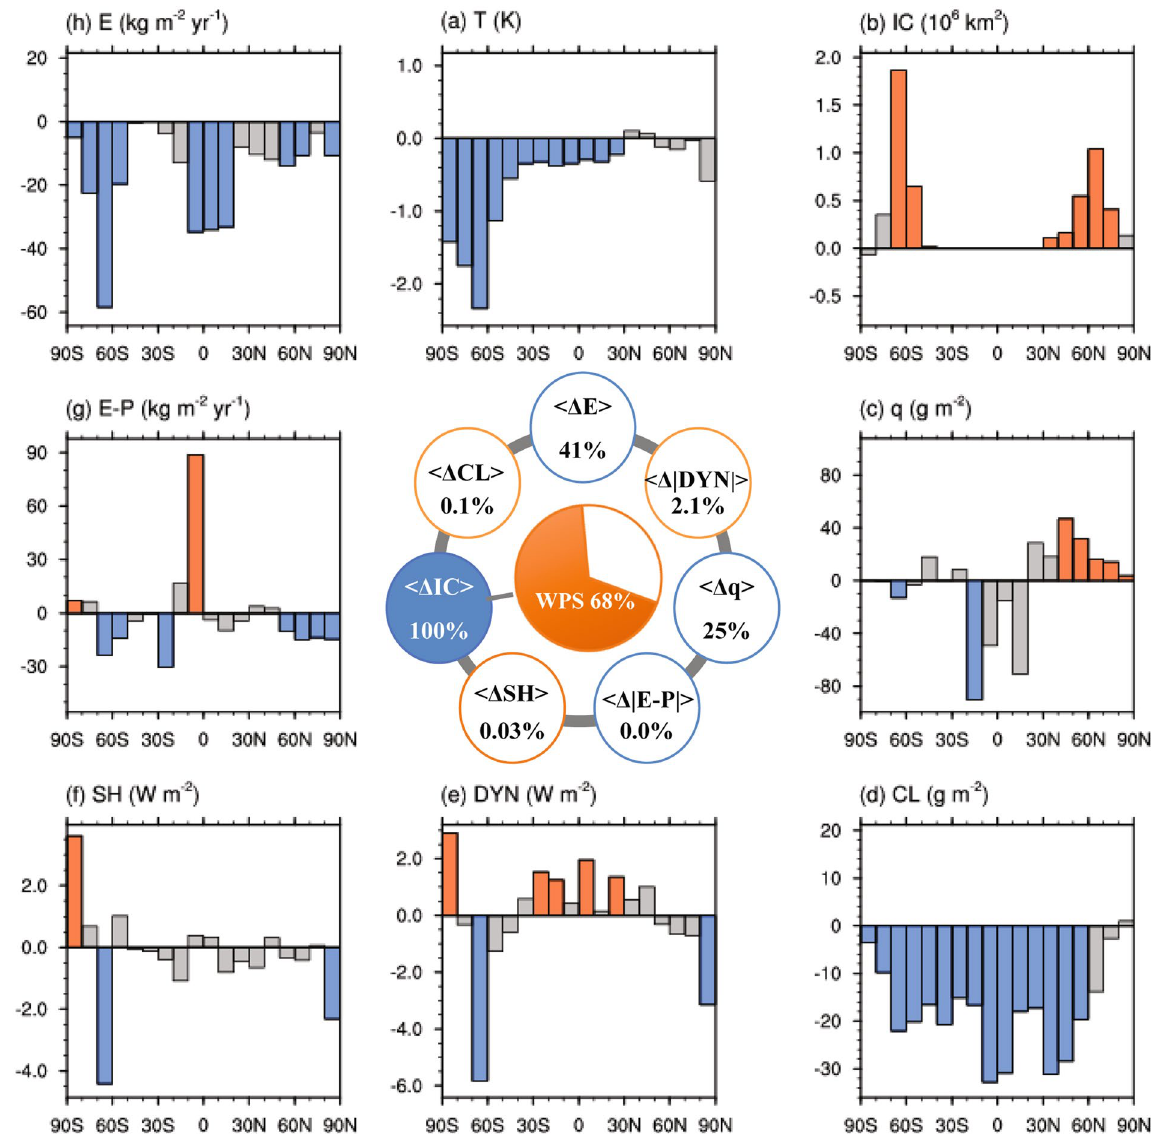
Figure 3. Latitudinal profiles (outer panels) of the regressed spreads of the zonal mean control climate states ( a – h ) against the projected spread in the change of total area coverage by ice/snow. ( a ) Surface temperature ( T in units of K), ( b ) total area covered by ice/snow ( IC in units of km 2 ), ( c ) vertically integrated atmospheric water vapor content ( q in units of g m − 2 ), ( d ) vertically integrated cloud water/ice content ( CL in units of g m − 2 ), ( e ) net downward radiative fluxes at TOA which measures the strength of the total atmosphere-ocean energy transport ( DYN in units of W m − 2 ), ( f ) surface sensible heat flux ( SH in units of W m − 2 ), ( g ) difference between surface evaporation rate and precipitation rate ( E − P in units of kg m − 2 yr − 1 ), and ( h ) precipitation rate ( P in units of kg m − 2 yr − 1 ). The numbers inside the circles of the inner panel correspond to the percentage of the spread, in the global mean changes of the eight key climate state variables that can be explained by the spread in the change of total ice/snow area coverage. Orange and blue colored (grey) bars indicate the correlation coefficients (do not) exceed 90% confidence